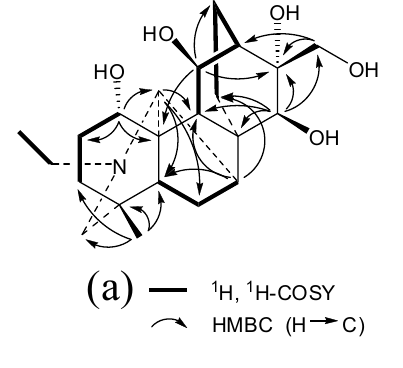
Figure 2. ( a ) Key 1 H, 1 H-COSY and HMBC correlations of aconicarmine ( 1 ); ( b ) Key ROESY correlations of aconicarmine ( 1